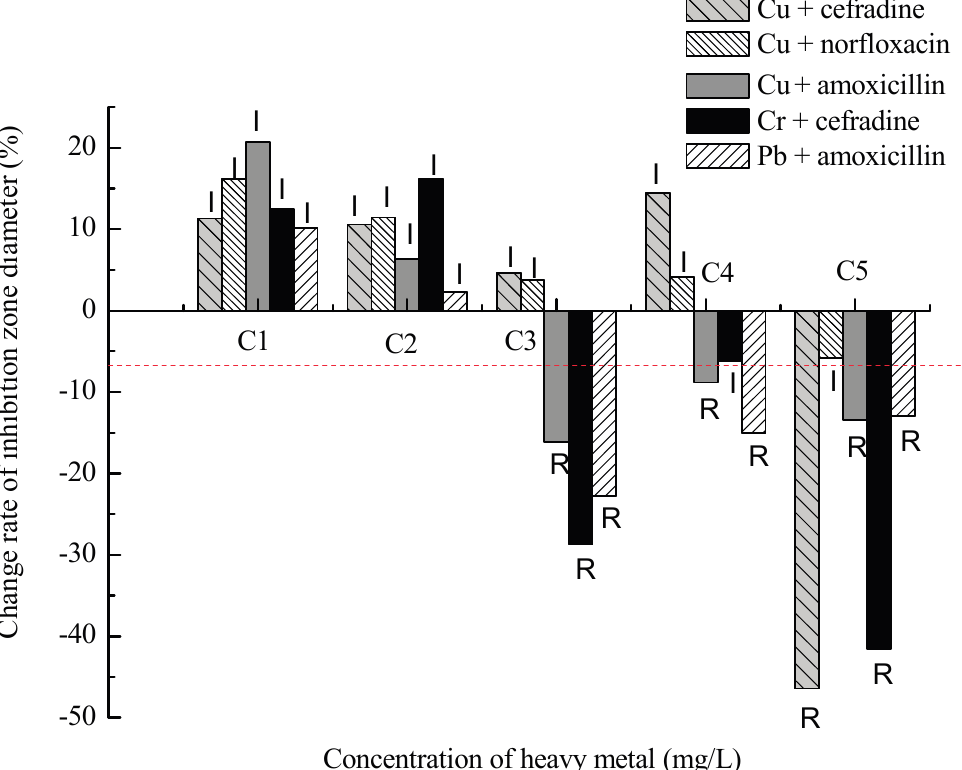
Figure 2. Effect of heavy metals on antibiotic resistance turning from antagonistic to synergistic with their concentrations increasing. R (Resistant), I (Intermediate) and S (Sensitive) of the CLSI category were labeled on each column. C1, C2, C3, C4, C5 were the effective concentrations of heavy metal in the medium, that is, Pb 2+ of 0.06, 1.66, 9.25, 49.37, 98.02 mg/L, Cu 2+ of 0.07, 1.66, 9.96, 46.17, 98.68 mg/L, and Cr 6+ of 0.06, 1.88, 19.18, 46.70, 77.59 mg/L, respectively. The red lines are the critical values of change rates which are counted according to the CLSI category shown in Table 1, and the symbols of “R”, “I” or “S” are the results of the comparison between the change rate and the critical value of the same